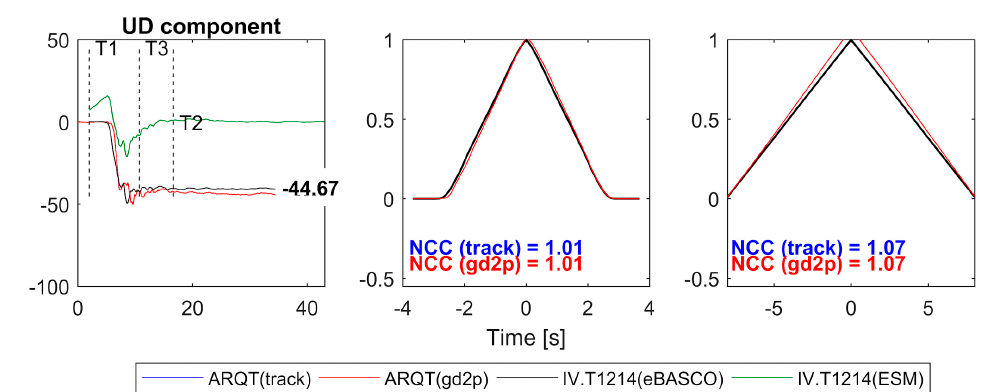
Figure A2. Comparison between displacement time series (two horizontal and vertical component) obtained by the eBASCO method (black line) and from the ESM database (green line) recorded at the IV.T1214 station during the Mw6.5 Norcia earthquake and HRGPS time series from the co-located ARQT station. The coseismic displacement measured by HRGPS is also reported in the 1st column of each plot together with the correction points (T 1 , T 2 and T 3 ). Normalized autocorrelation function (ACC) (black line) and normalized cross-correlation (NCC) function between HRGPS and eBASCO displacement (red line) are shown in the 2nd and 3th columns. ACC and NCC were calculated between T1 and T2 (2nd column) and between T3 and the end of signal (3th column); dist: interdistance between strong-motion and GPS station; srt: sampling rate of the HRGPS records; gd2p and track: different processing schemes of the HRGPS data